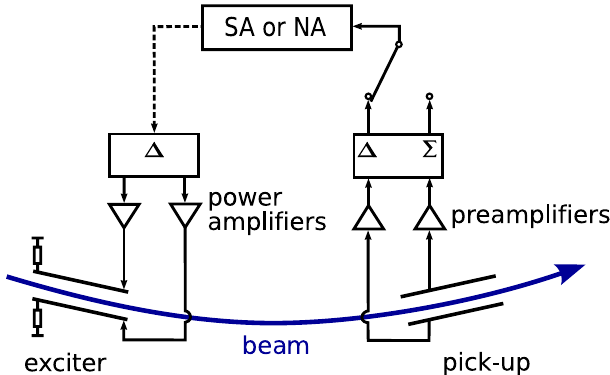
FIG. 1. (Color) The hardware for Schottky and BTF diagnostics. The dashed arrow refers to BTF measurements with a network analyzer (NA) only. In this case only the difference ( (cid:1) ) signal from the detector is useful. For Schottky measurements, a spectrum analyzer (SA) is connected to the difference or sum ( (cid:3) ) signal of the pickup.